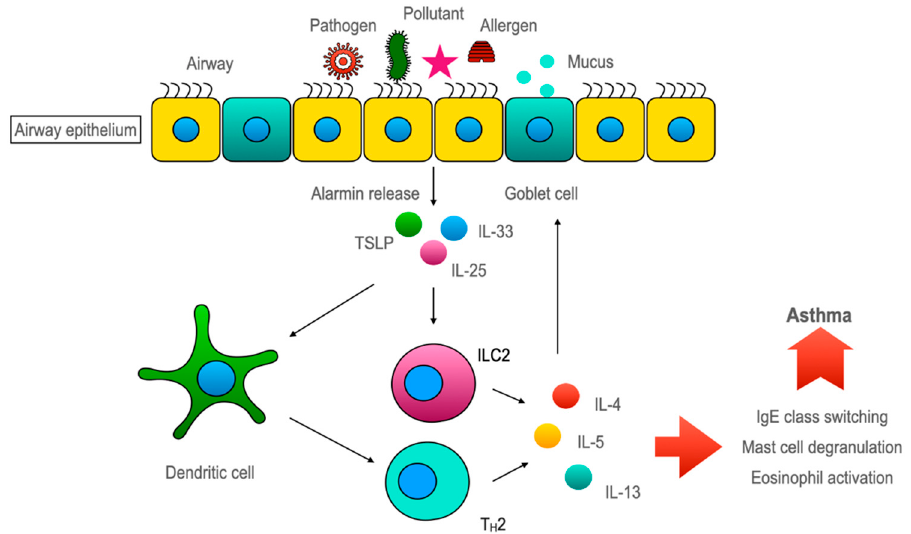
Figure 3. Airway epithelia regulating epi-immune response upon allergen/pathogen exposure. Pathogens or allergens disrupt the airway epithelia. Disrupted epithelia releases alarmins (IL-25, IL-33, and TSLP). Alarmins activate dendritic cells for Th2 polarization of the immune response. On the other hand, alarmins can directly activate ILC2 cells to secret IL-4, IL-5, and IL-13 cytokines.